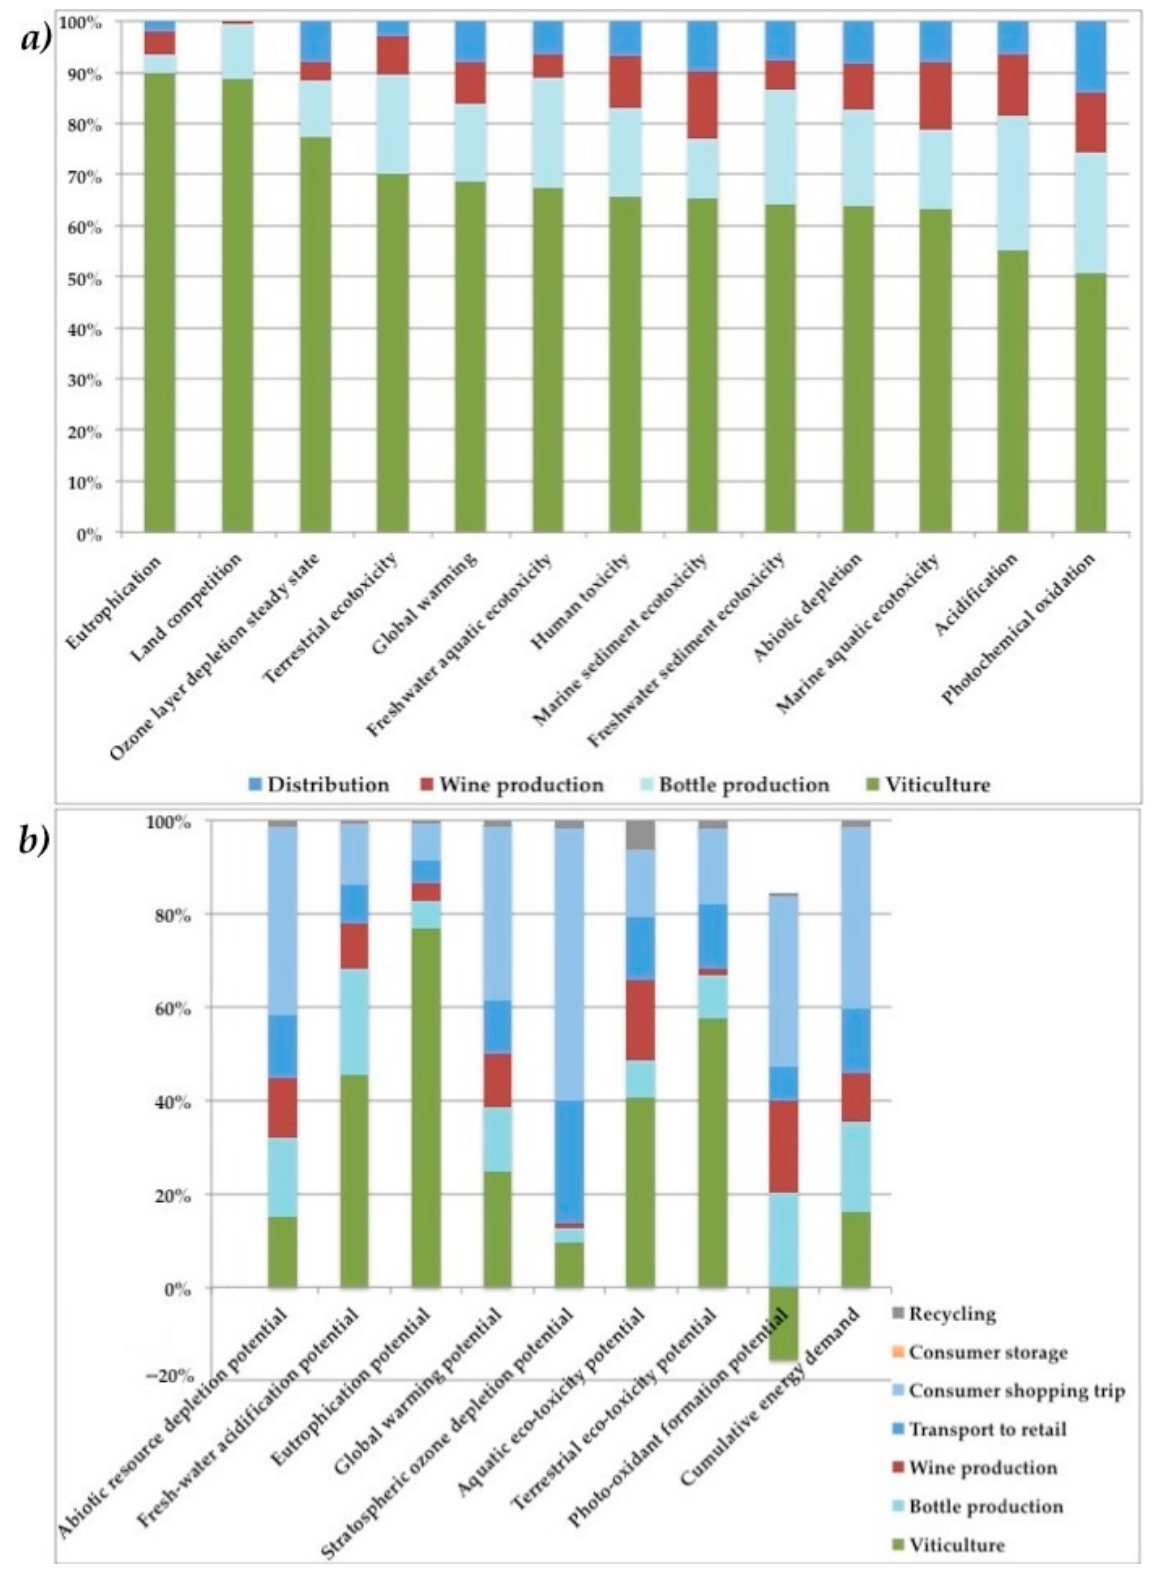
Figure 3. Percentage contribution of the stages of the wine supply chain to the various impact categories in life cycle assessment (LCA) studies applied to ( a ) vinho verde Portuguese wine (adapted from Neto et al.) and ( b ) a Canadian wine made with locally grown grapes (adapted from Point et al.) [66,67].